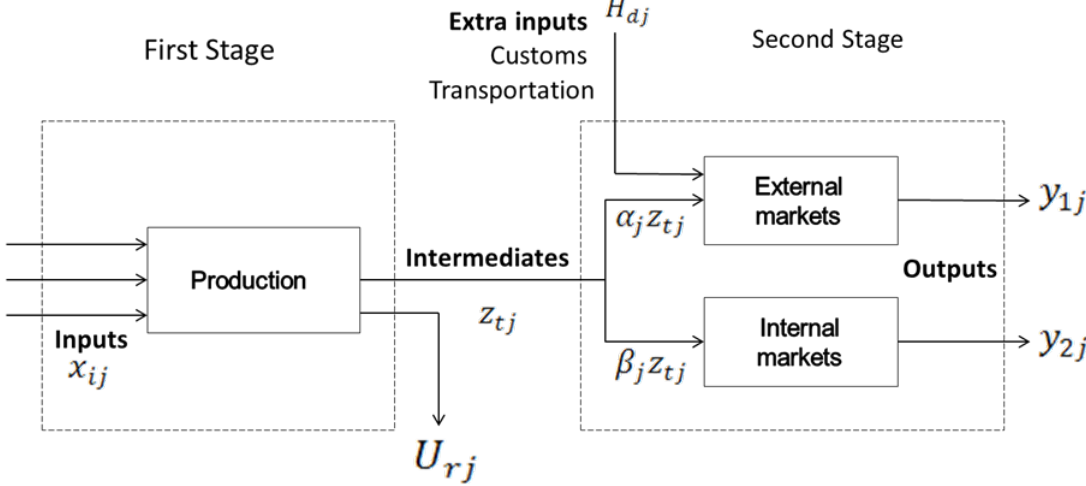
Fig. 1. Multistage structure of Iranian Handmade Carpet Industry